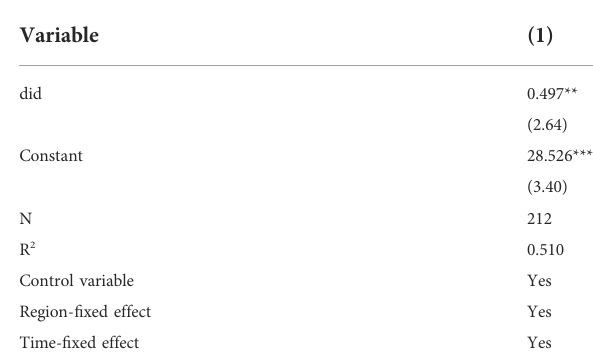
TABLE 3 Regression results of